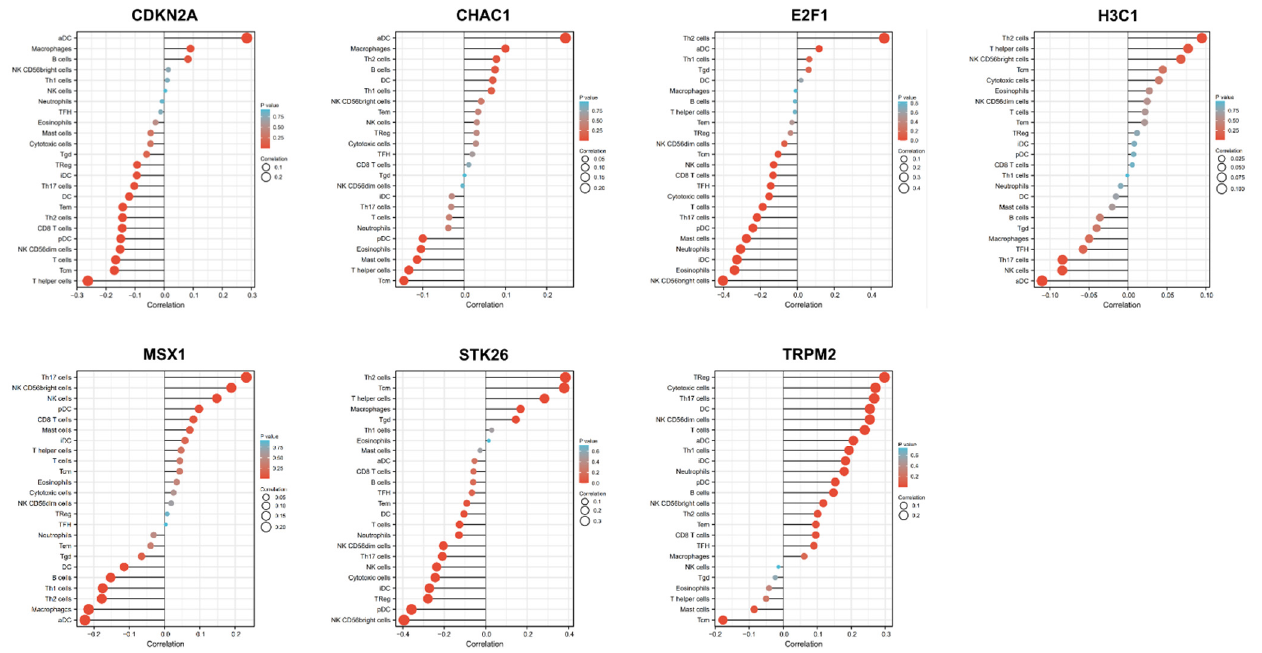
Figure 8. The correlation between the expression level of H3C1, CDKN2A, E2F1, CHAC1, STK26, TRPM2 and MSX1 with 22 immune cell types.